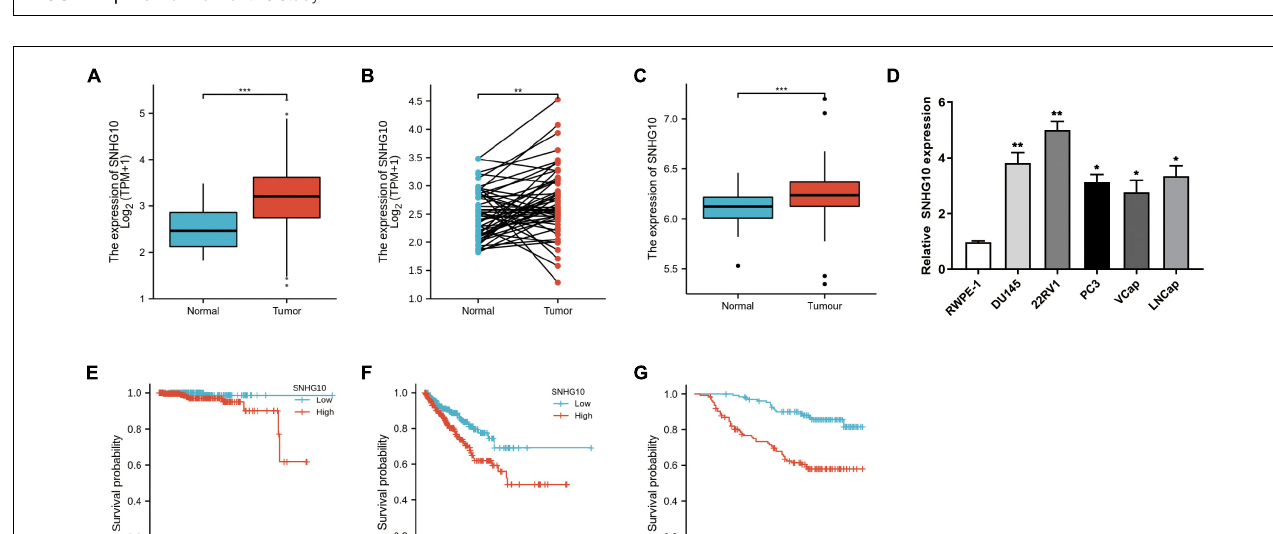
Frontiers in Cell and Developmental Biology |